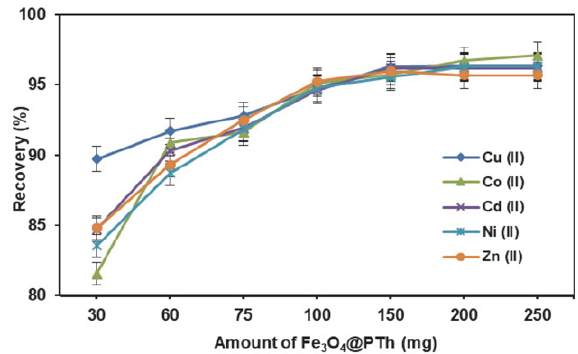
Figure 4. Effect of the amount of the Fe 3 O 4 @PTh on the recoveries of the analyte ions (n = 3)